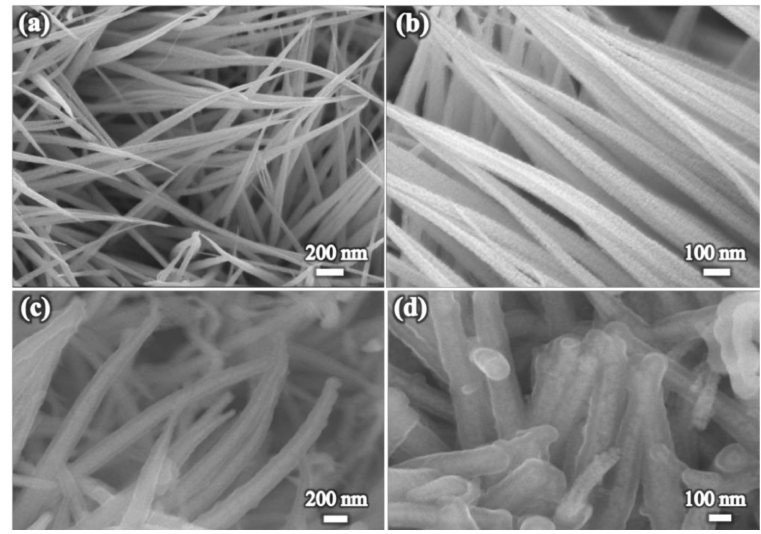
Figure 1. Scanning electron microscopy (SEM) images of ( a , b ) CoO nanowires on carbon cloth, ( c , d ) hybrid core-shell CoO@Ppy nanoarrays on carbon